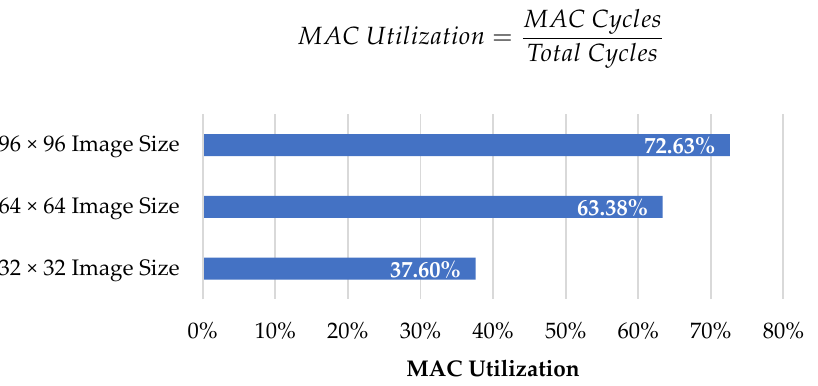
Figure 8. MAC utilization for different image sizes.